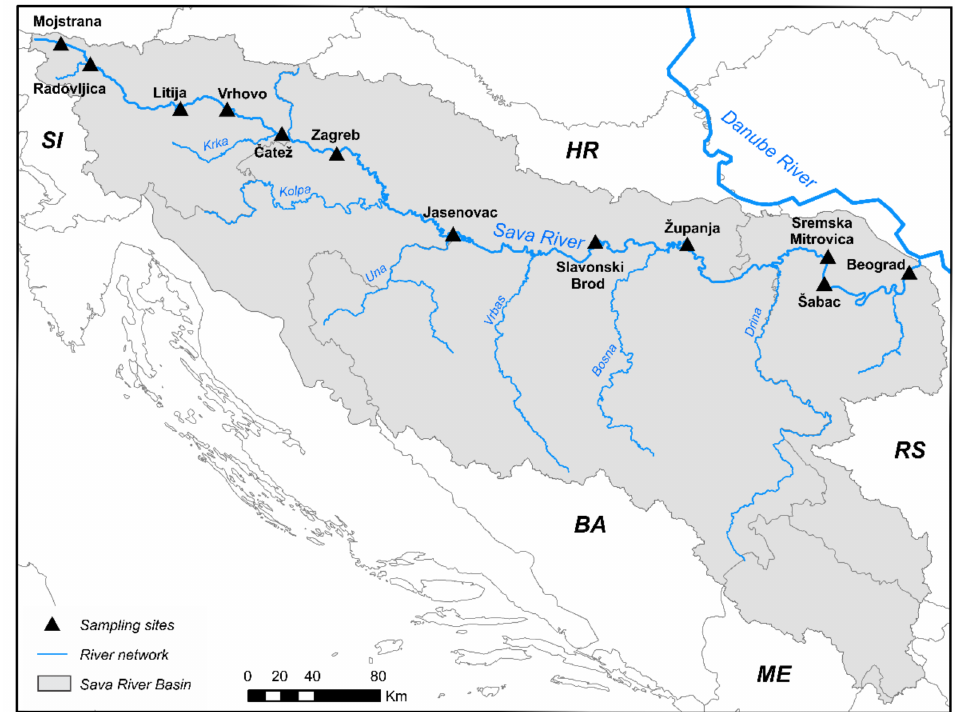
Figure 1. Location of the Sava River sampling